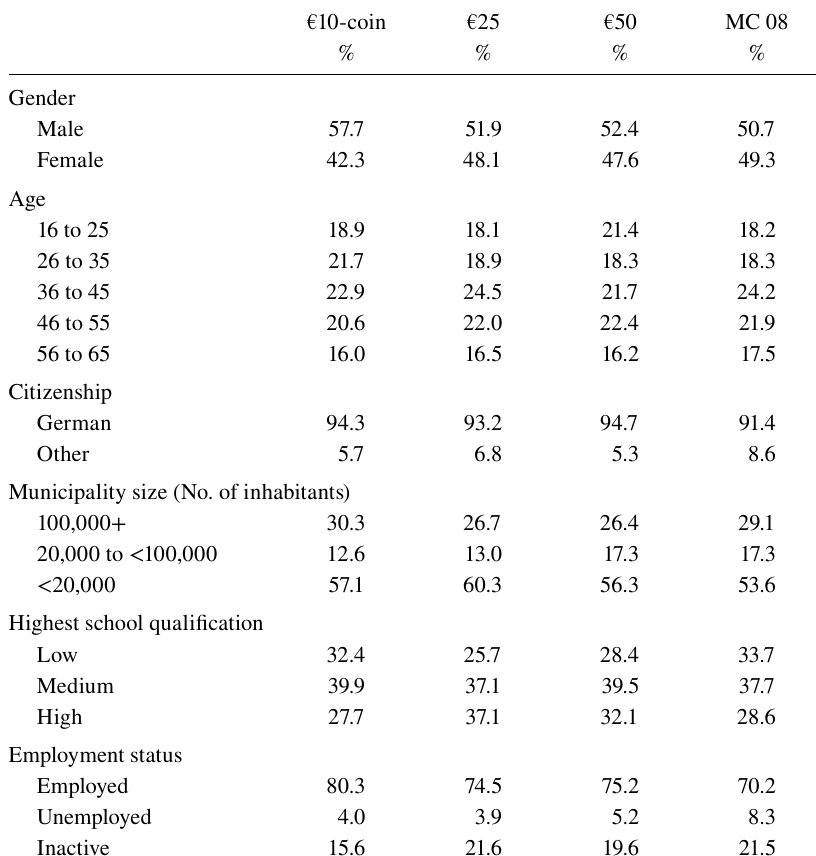
Comparison of survey estimates with German Microcensus data